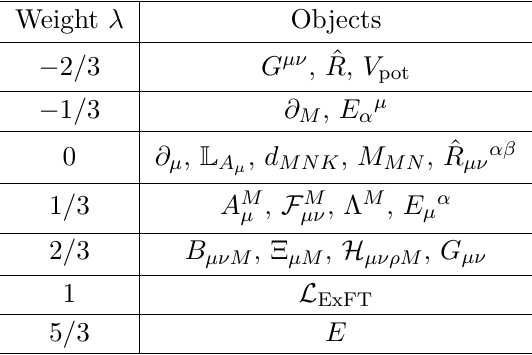
Table 1 . The exceptional generalised diffeomorphism weights of the most important objects of E exceptional field 6(6)